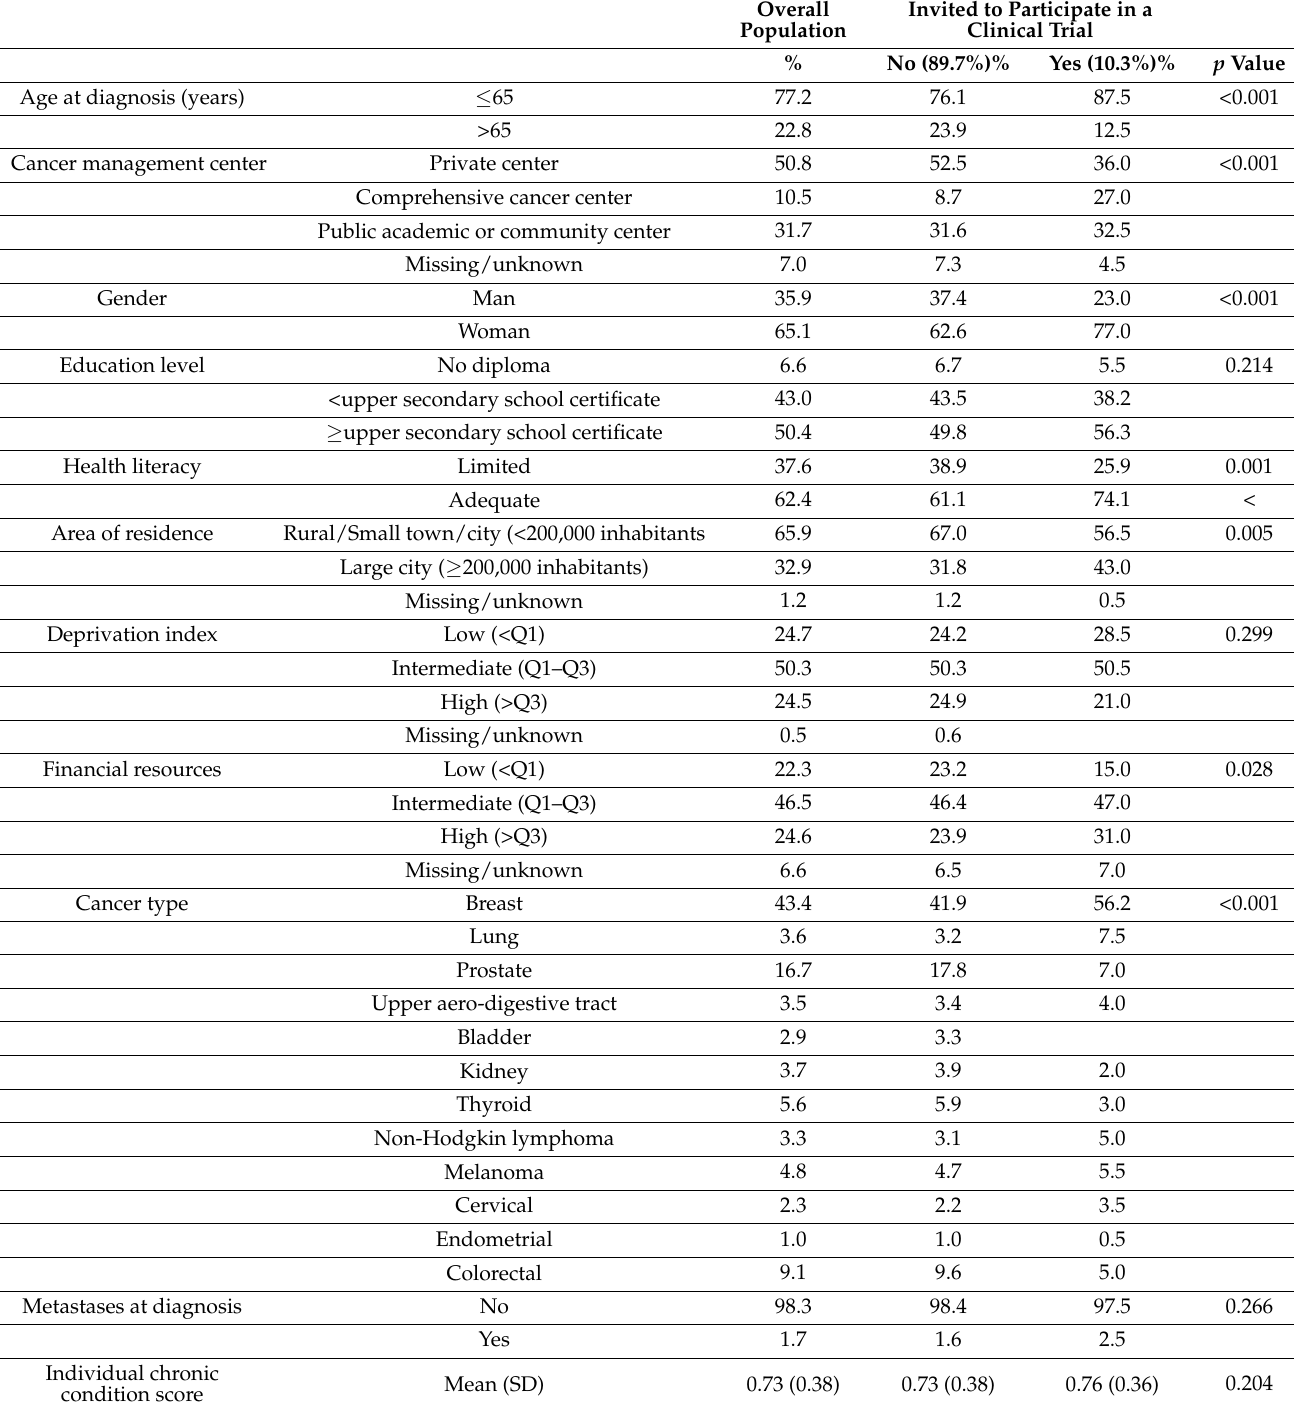
Table 1. Main patient characteristics as a function of invitation to participate in a clinical trial (N = 1954).